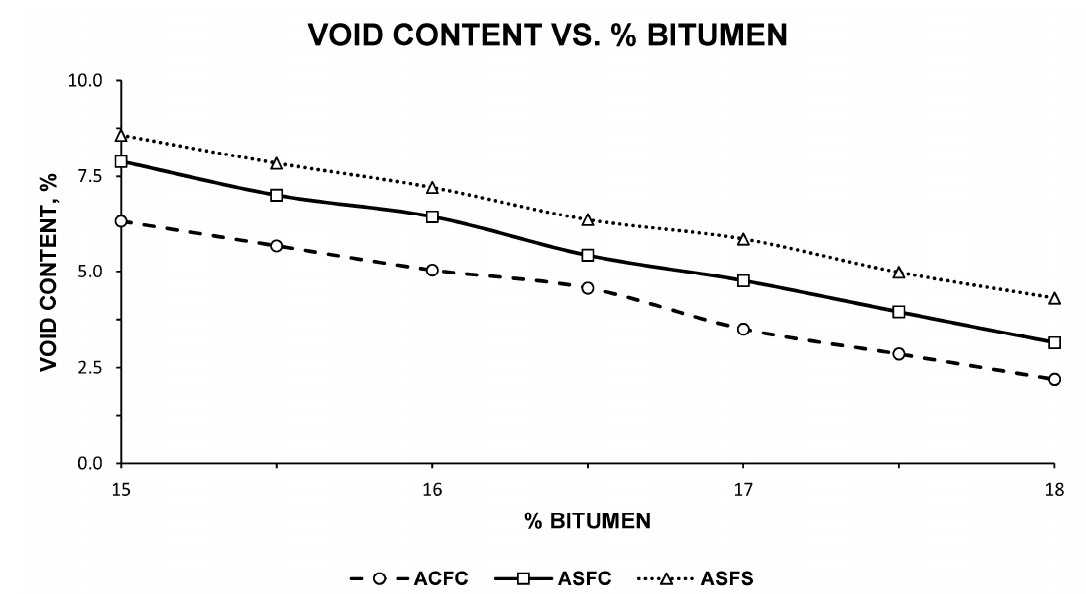
Figure 5. Void content of the families of bituminous mixtures ACFC, ASFC and ASFS with different percentages of bitumen in volume of aggregate.